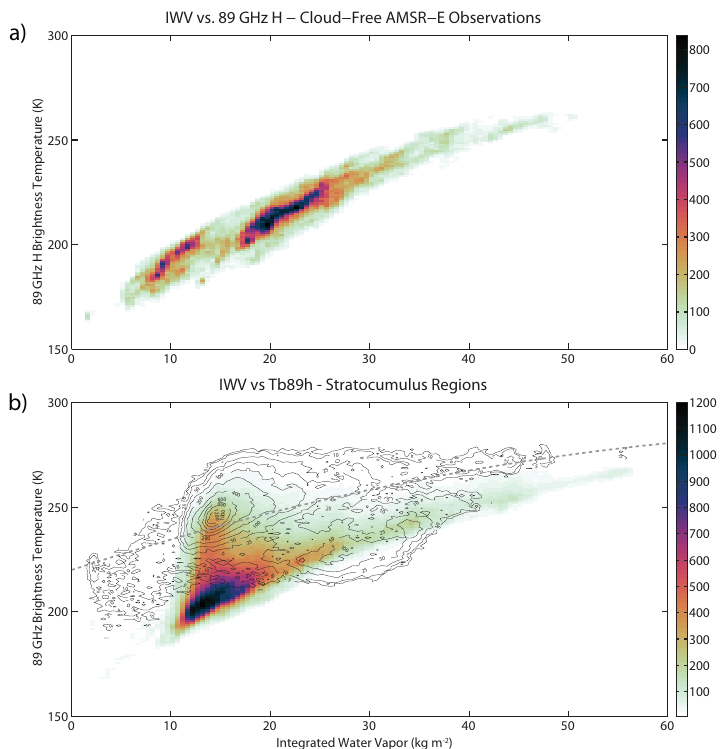
Fig. 2. (a) Scatter density plot of IWV versus T 89H for cloud-free AMSR-E pixels from randomly selected scenes between 60 ◦ N and 60 ◦ S latitude. (b) Scatter density plot of IWV versus T 89H for 4409366 pixels from 45 randomly selected marine stratocumulus scenes containing detectable drizzle. The contours denote the counts for the subset of points with LWP values ≥ 200gm − 2 . The dashed grey line denotes the threshold curve for drizzle